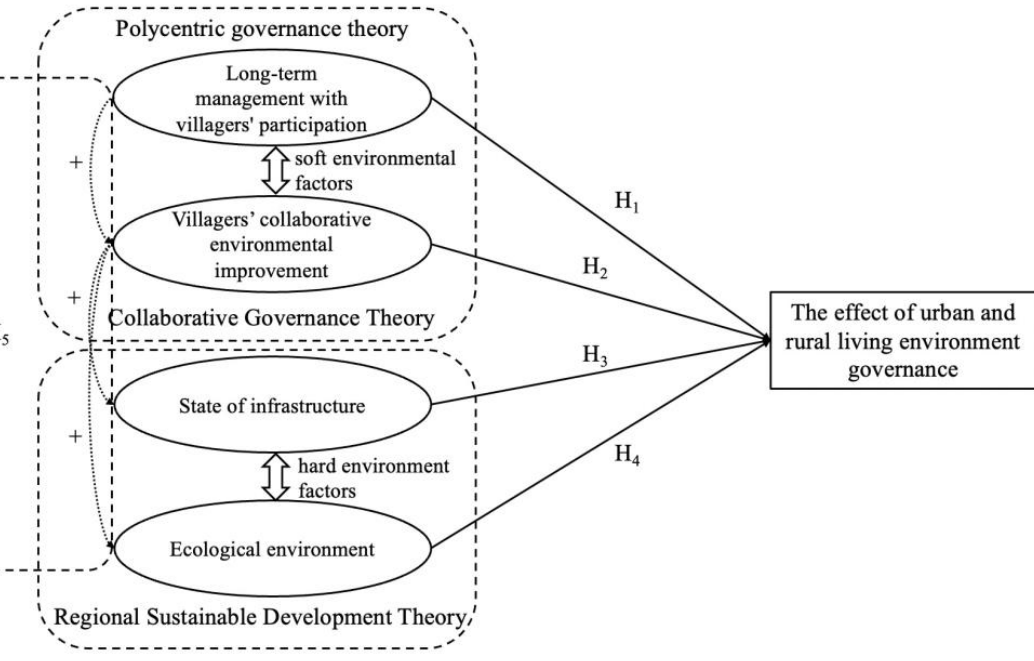
Figure 1. Theoretical analysis framework.